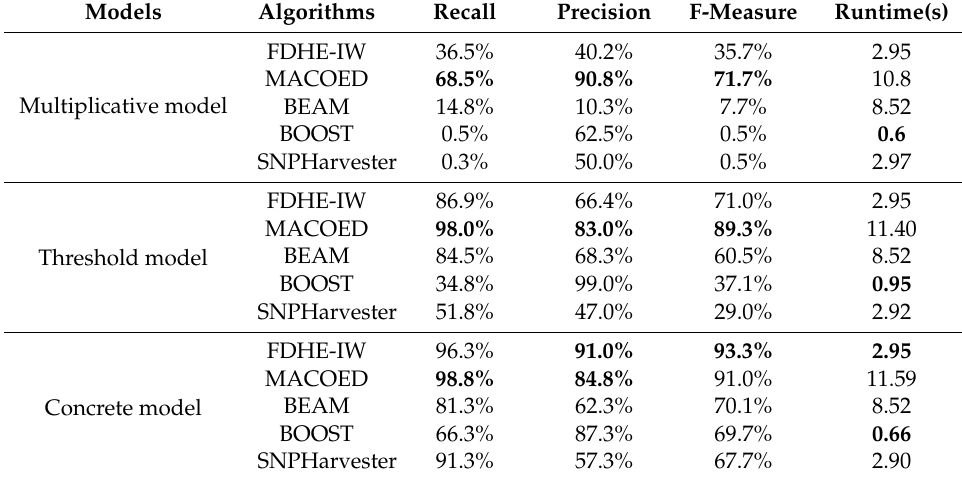
FDHE-IW: A fast approach for detecting high-order epistasis with interaction weight; MACOED: Multi-objective ant colony optimization epistasis detection; BEAM: Bayesian epistasis association mapping; BOOST: Boolean operation-based screening and